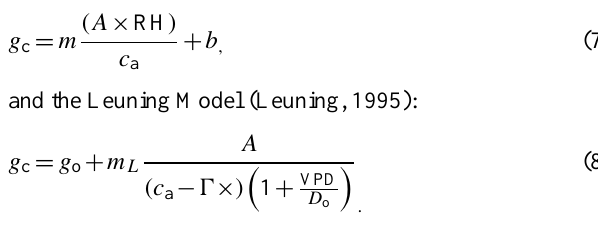
* Indicates tall tower sites. a Indicates regressions where the atmospheric vapor terms (i.e. VPD or RH) have been transformed by the natural logarithm and correlated with δ s . b Indicates linear regressions between the atmospheric vapor pressure term (i.e. VPD or RH) and δ s